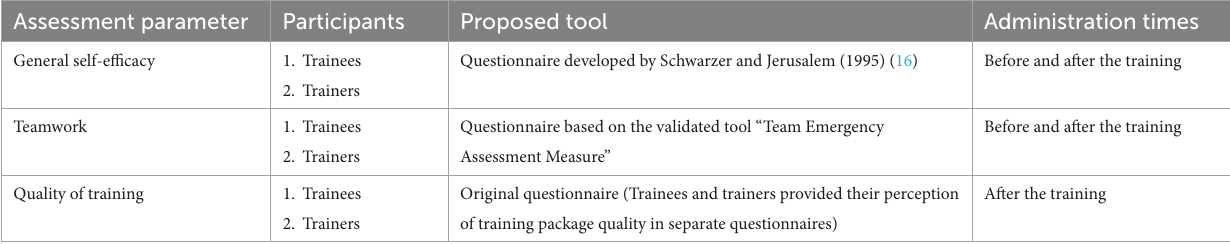
TABLE 3 Summary of evaluation methodology and assessment tools